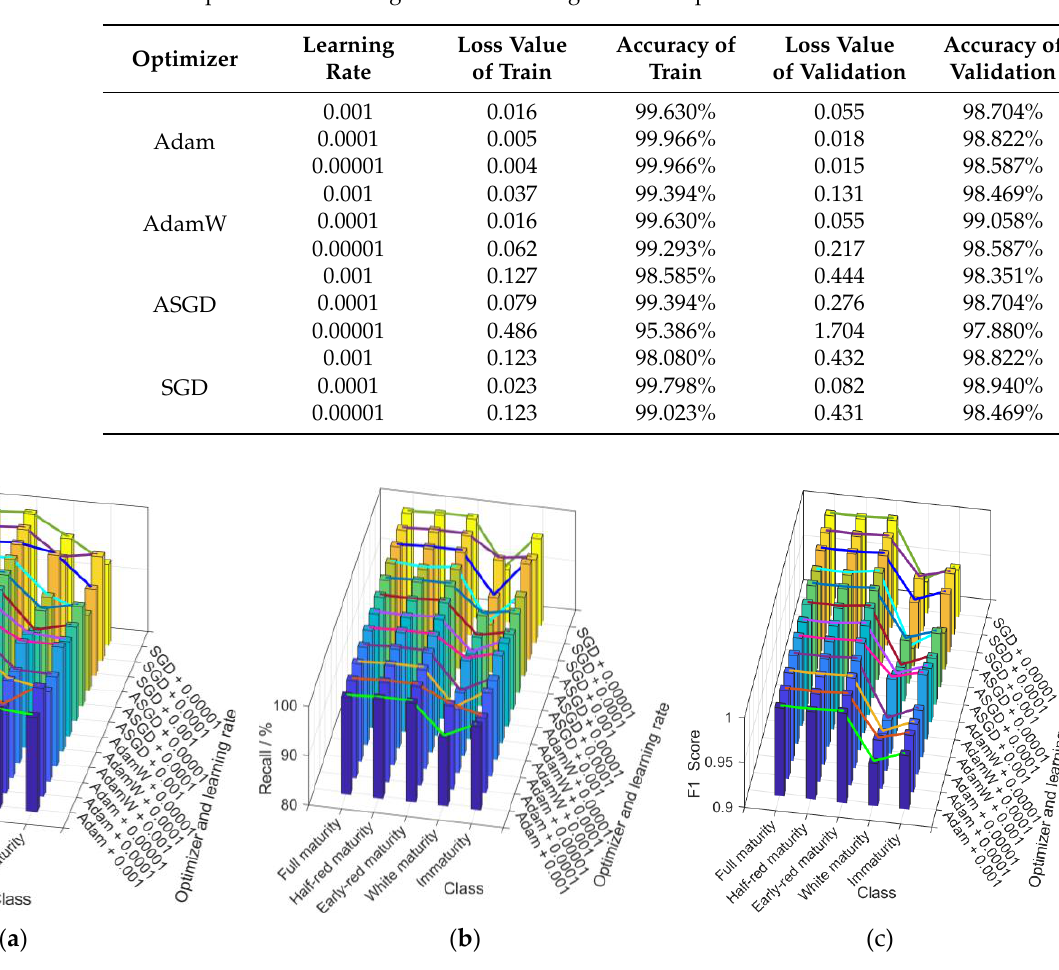
Table 3. Results of ablation experiment. Class Balance